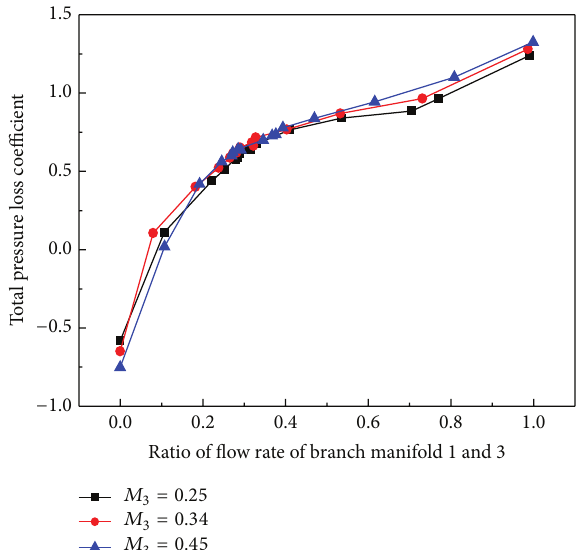
Figure 6: Pressure difference from branch manifold 1 to branch manifold 3.